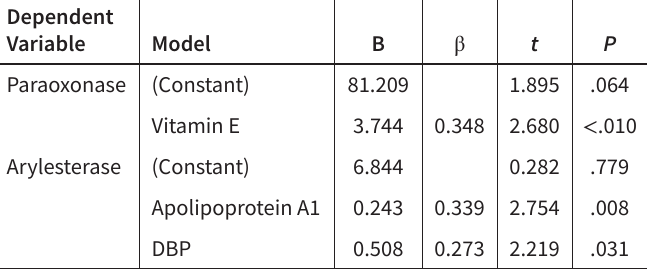
Table 5. Determinants of Paraoxonase and Arylesterase Activities by Multiple Regression